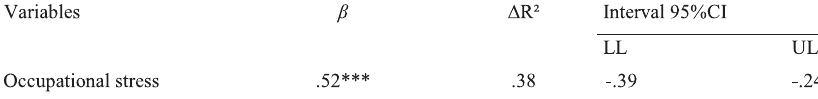
Table 1 indicated the demographic information of school teachers regarding their gender, sector, marital status and education. Table 2 Linear regression analysis showing the impact of occupational role stress on Life satisfaction among Teachers